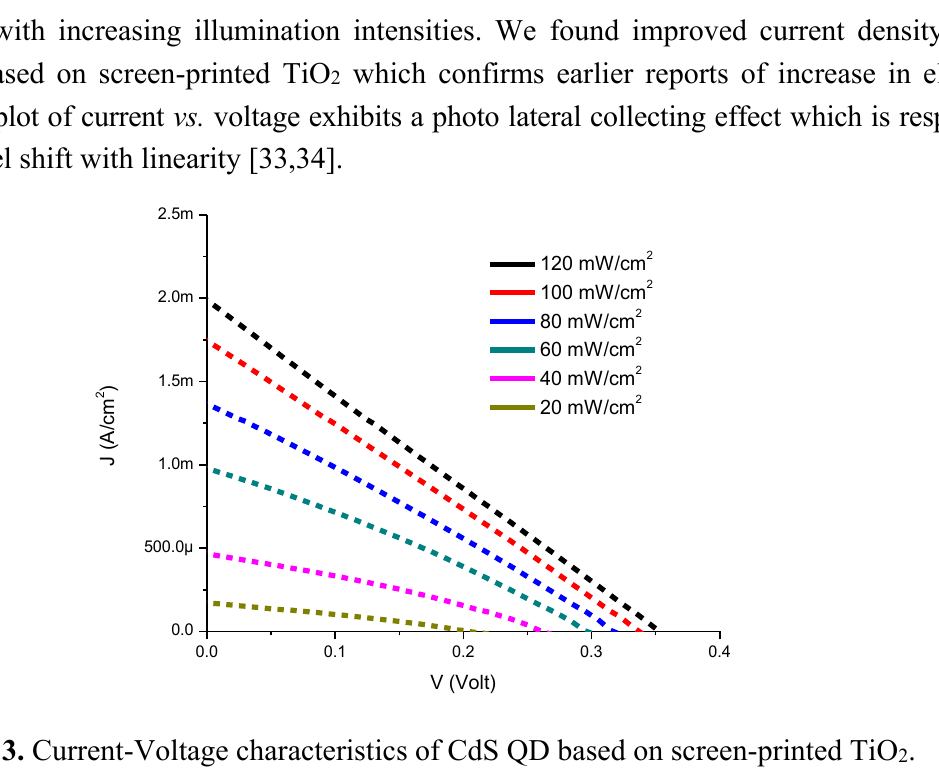
Figure 3. Current-Voltage characteristics of CdS QD based on screen-printed TiO 2